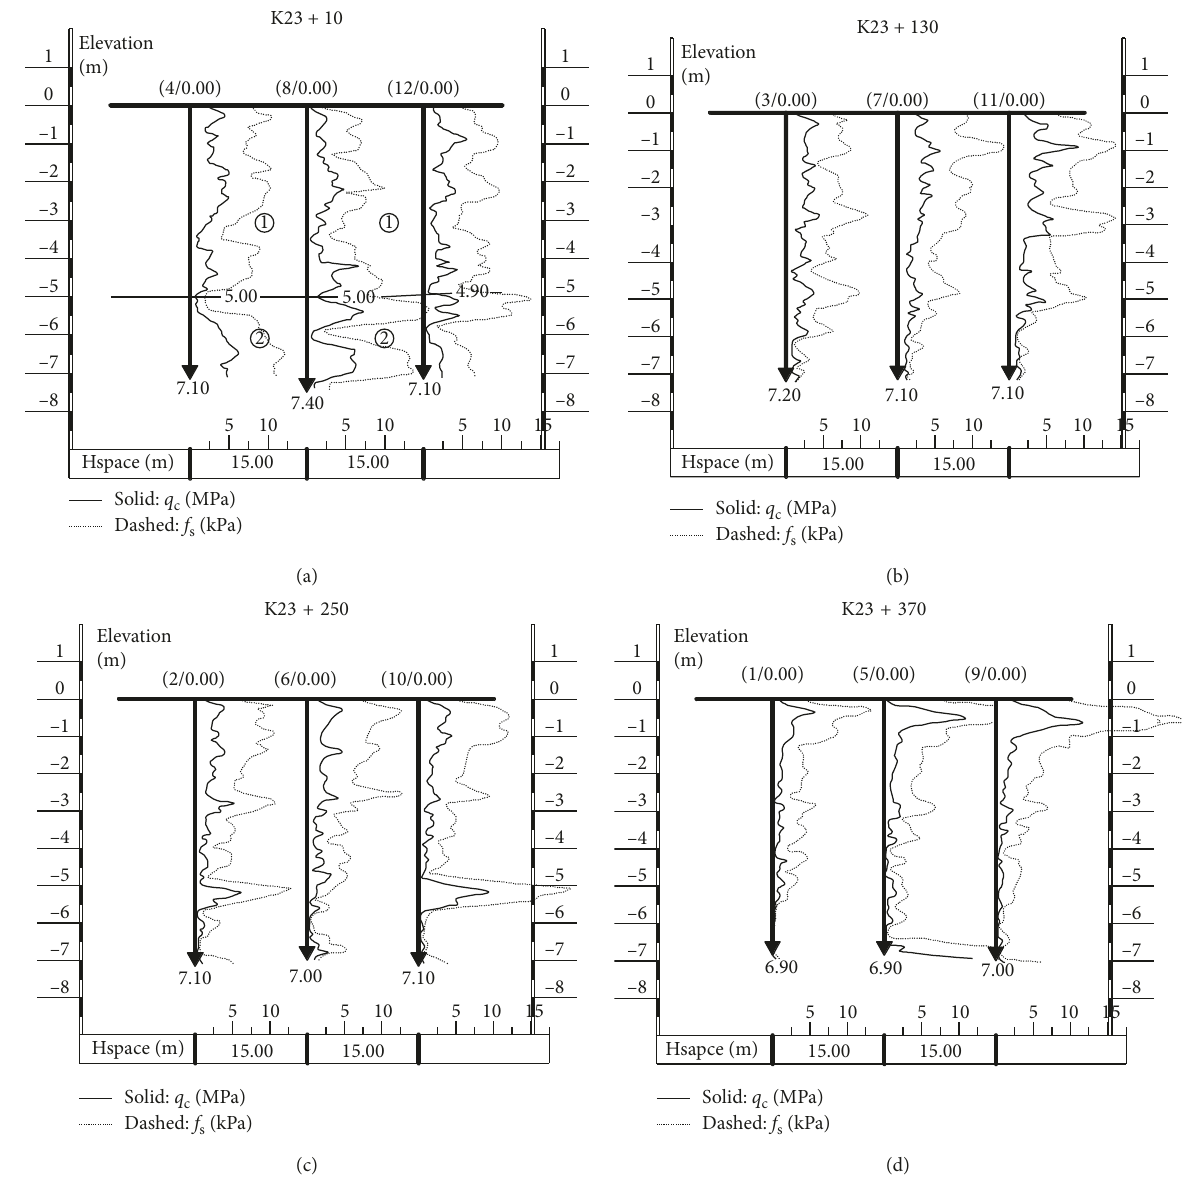
Figure 7: Results of